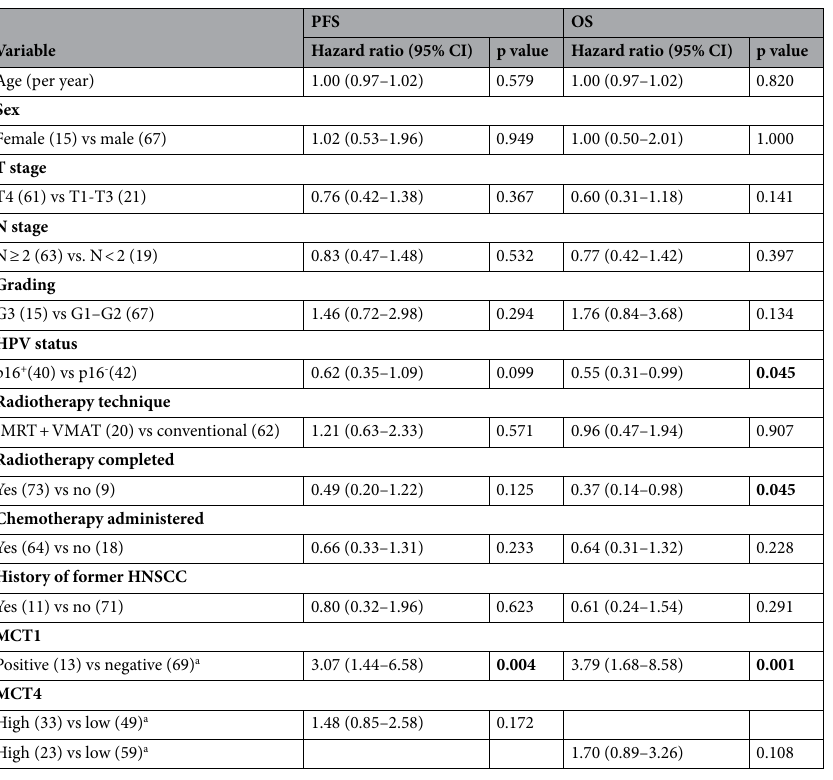
Table 3. Basic patient and clinical features in relation to progression-free (PFS) and overall (OS) survival assessed by multivariable analysis including all the designated variables. P values < 0.05 are indicated in bold. a Cutoff determined by “Cutoff Finder”. For MCT4, different cutoffs were determined for PFS (score 165 as defined in “Methods”) and OS